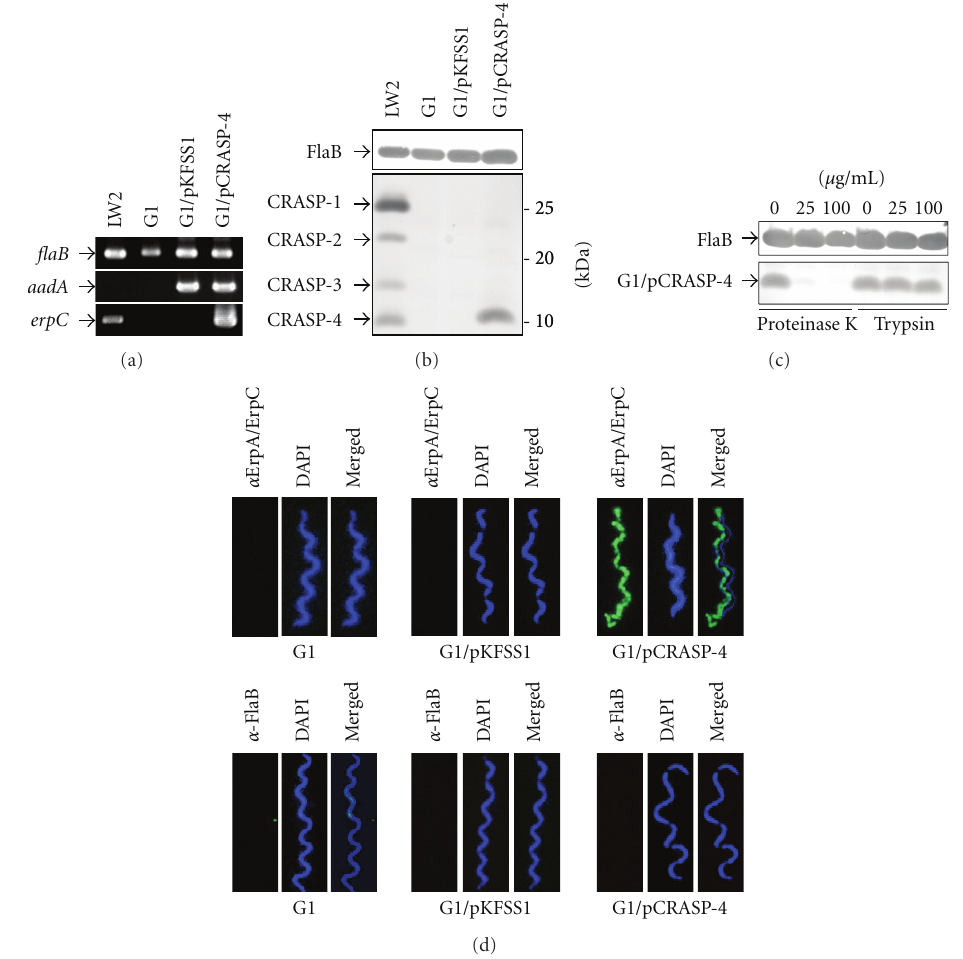
Figure 3: Characterization of B. garinii G1 producing CRASP-4. (a) B. garinii G1 and transformed strains G1/pKFSS1 and G1/pCRASP- 4 were characterized by PCR amplification using flaB- , aadA- , and erpC -specific primers, as listed in Table 1. (b) Synthesis of CRASP-4 by transformed G1 was assessed using ligand a ffi nity blotting. Whole cell lysates (15 μ g each) of G1, G1/pKFSS1 and G1/pCRASP-4 were separated by SDS-PAGE, and transferred to nitrocellulose. After incubation with NHS, binding of CFH to CRASP-4 was identified using a polyclonal antiserum. A monoclonal antibody, L41 1C11, specific for the flagellin protein FlaB, was applied to show equal loading of borrelial lysates. (c) Surface localization of CRASP-4 in transformed G1 cells. Spirochetes were incubated with or without proteinase K or trypsin, respectively, then lysed by sonication, and total proteins were separated by SDS-PAGE. CRASP-4 was identified by ligand a ffi nity analysis as described above. Flagellin (FlaB) was detected with MAb L41 1C11 (dilution 1/1000) by Western blotting. (d) Demonstration of surface expression of CRASP-4 by transformed B. garinii G1, by indirect immunofluoresecence microscopy of intact borrelial cells. Spirochetes were incubated with rabbit polyclonal anti-ErpA/ErpC antiserum before fixation. Periplasmic FlaB, used as control, was detected by mAb L41 1C11 using fixed and unfixed cells. For counterstaining, the DNA-binding dye DAPI was used to identify all bacteria. Slides were visualized at a magnification of × 1,000 using an Olympus CX40 fluorescence microscope mounted with a DS-5Mc charge-coupled device camera